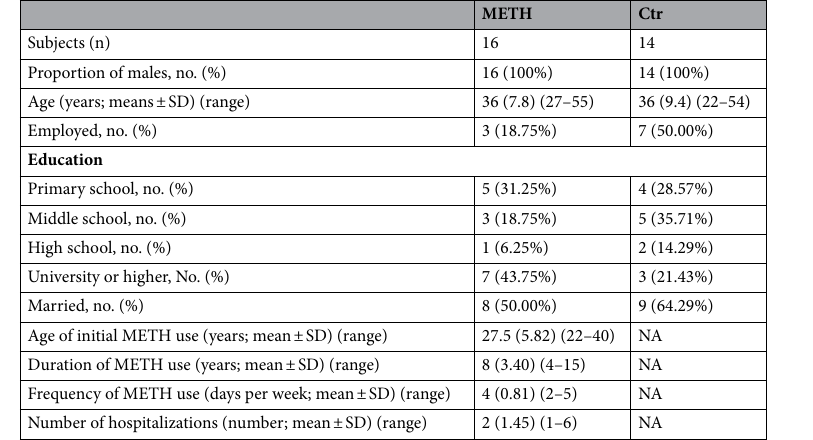
Table 1. Characteristics of the study